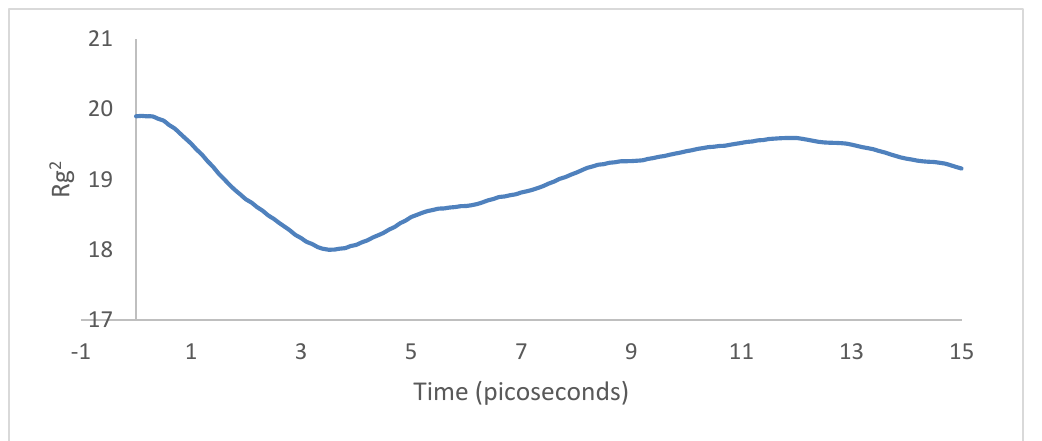
Figure 25. Radial distribution function: 4PPV–7 nm × 7 nm graphene (final).